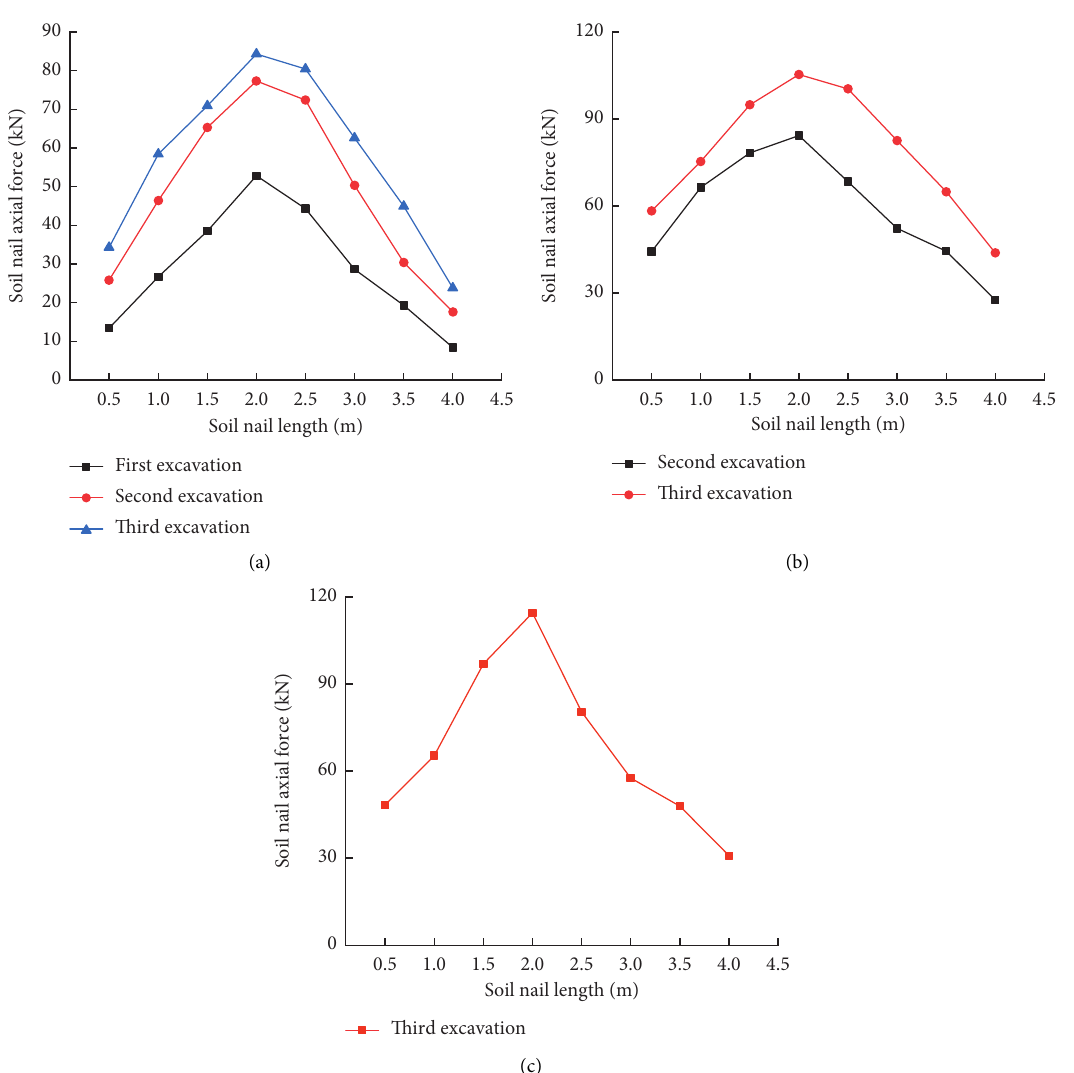
Figure 15: Soil nail axial force distribution curves in the excavation stage. (a) The first, (b) second, and (c) third rows of soil